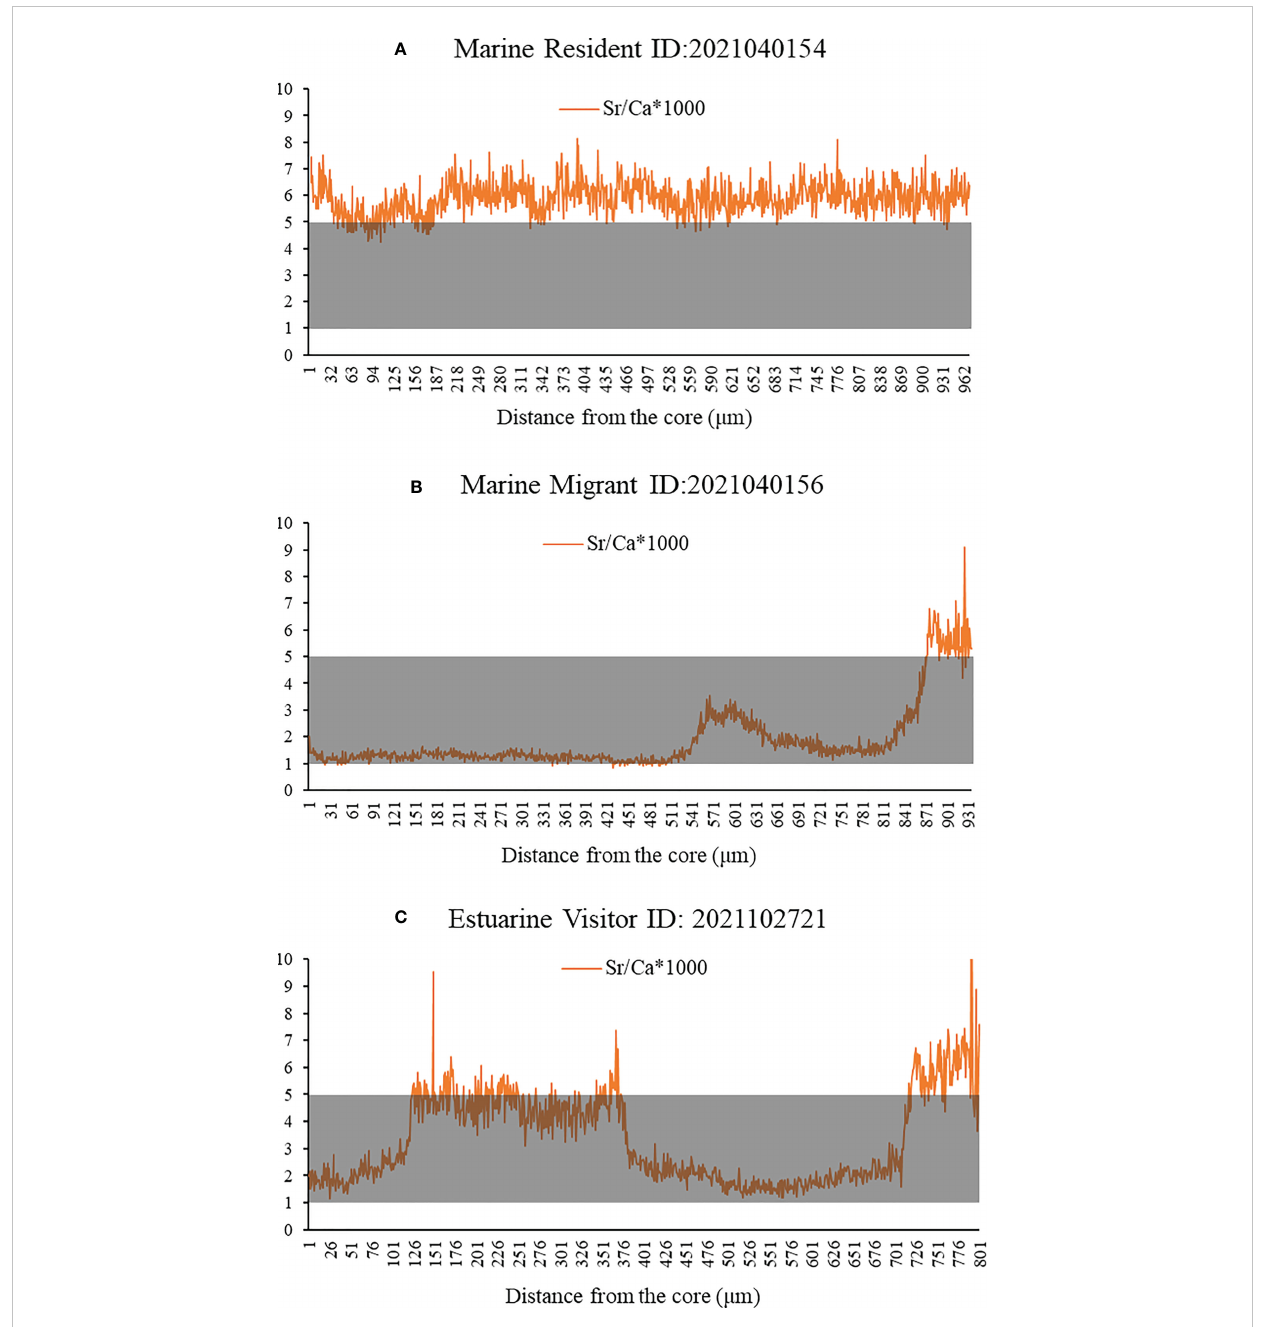
FIGURE 7 Types of pro fi les for the Sr/Ca ratios in otoliths of individuals from the RW. The grey area indicates that the individual lives in the low to middle salinity area. (A) The individuals of the Marine Resident pattern of movement. (B) The individuals of the Marine Migrant pattern of movement. (C) The individuals of the Estuarine Visitor pattern of